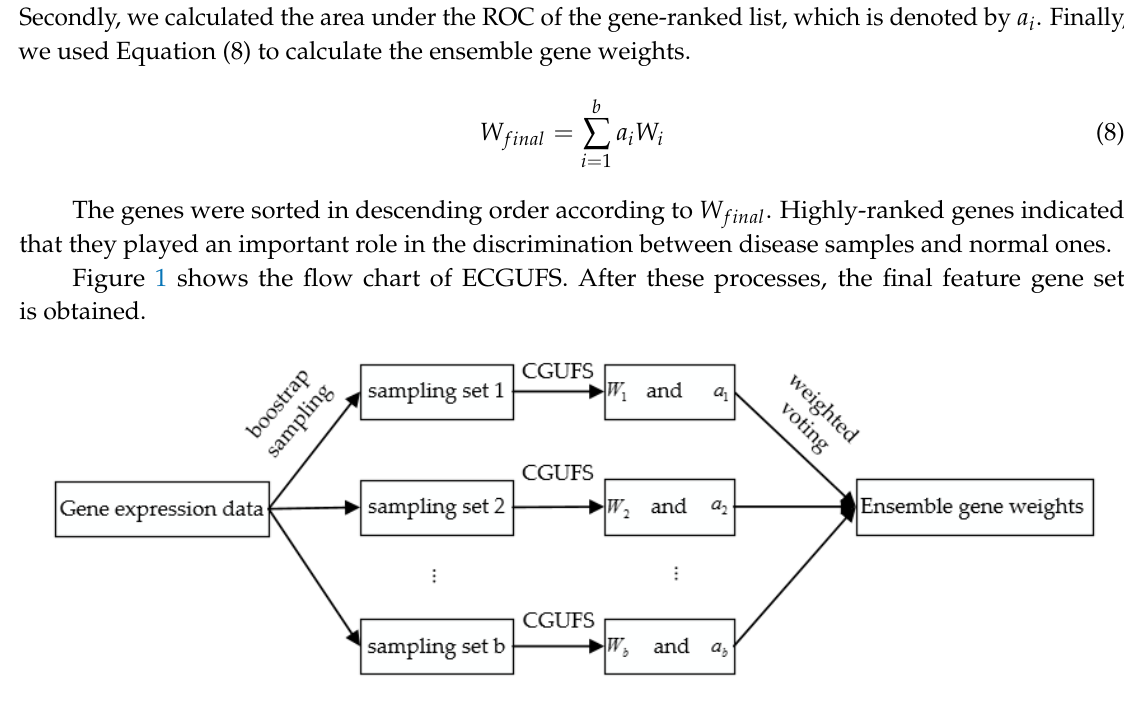
Figure 1. Flow chart of the ensemble consensus-guided unsupervised feature selection (ECGUFS) algorithm. Consensus-guided unsupervised feature selection (CGUFS); W i : a vector of weights for all genes; a i : the area under the receiver operating characteristic (ROC) curve of the gene-ranked